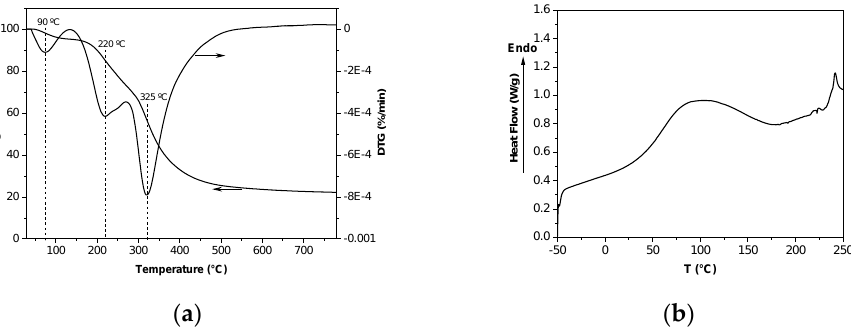
Figure 2. ( a ) Thermo-gravimetric analysis (TGA) and DTG curves, and ( b ) differential scanning calorimetry (DSC) curve of soy protein isolate (SPI) films.